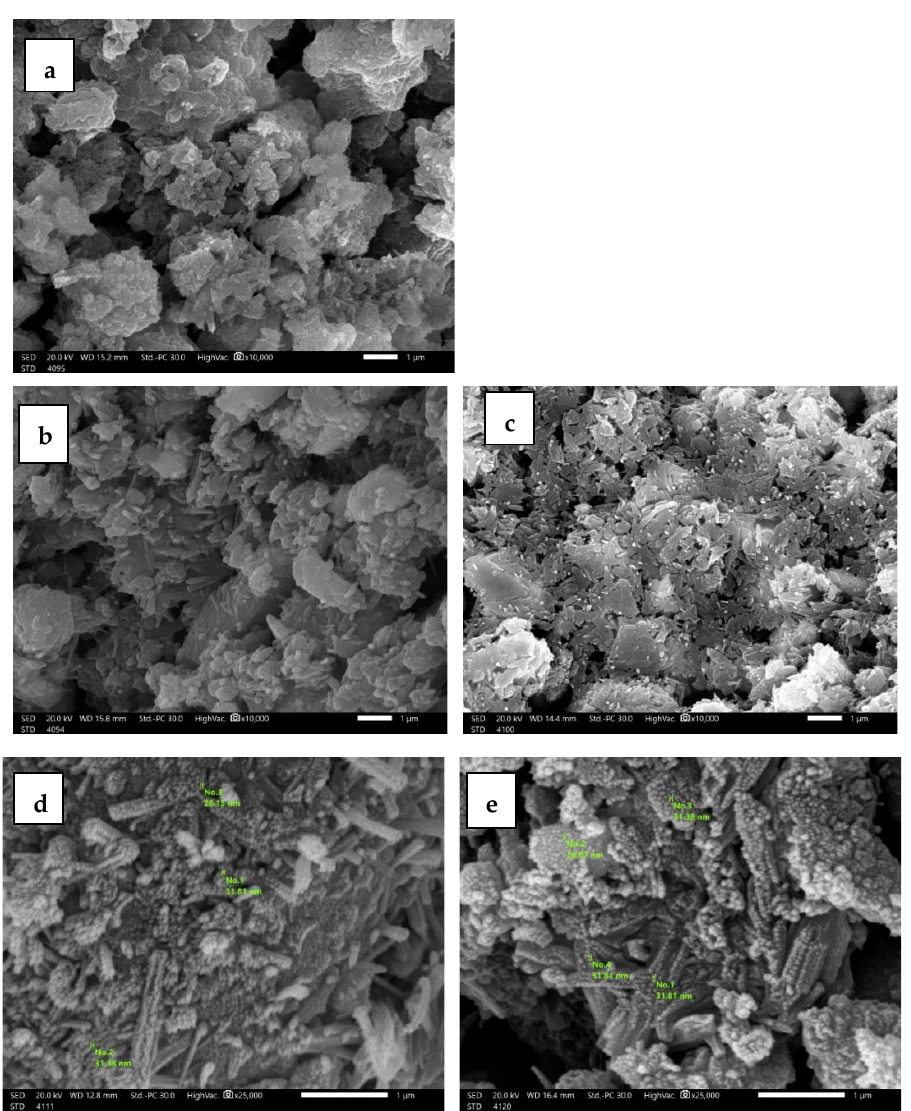
Figure 2. SEM images of the mortar prepared samples of ( a ) CS, ( b ) CS-mBi 2 O 3 15%, ( c ) CS-mBi 2 O 3 30%, ( d ) CS-nBi 2 O 3 15%, and ( e ) CS-nBi 2 O 3 30%.